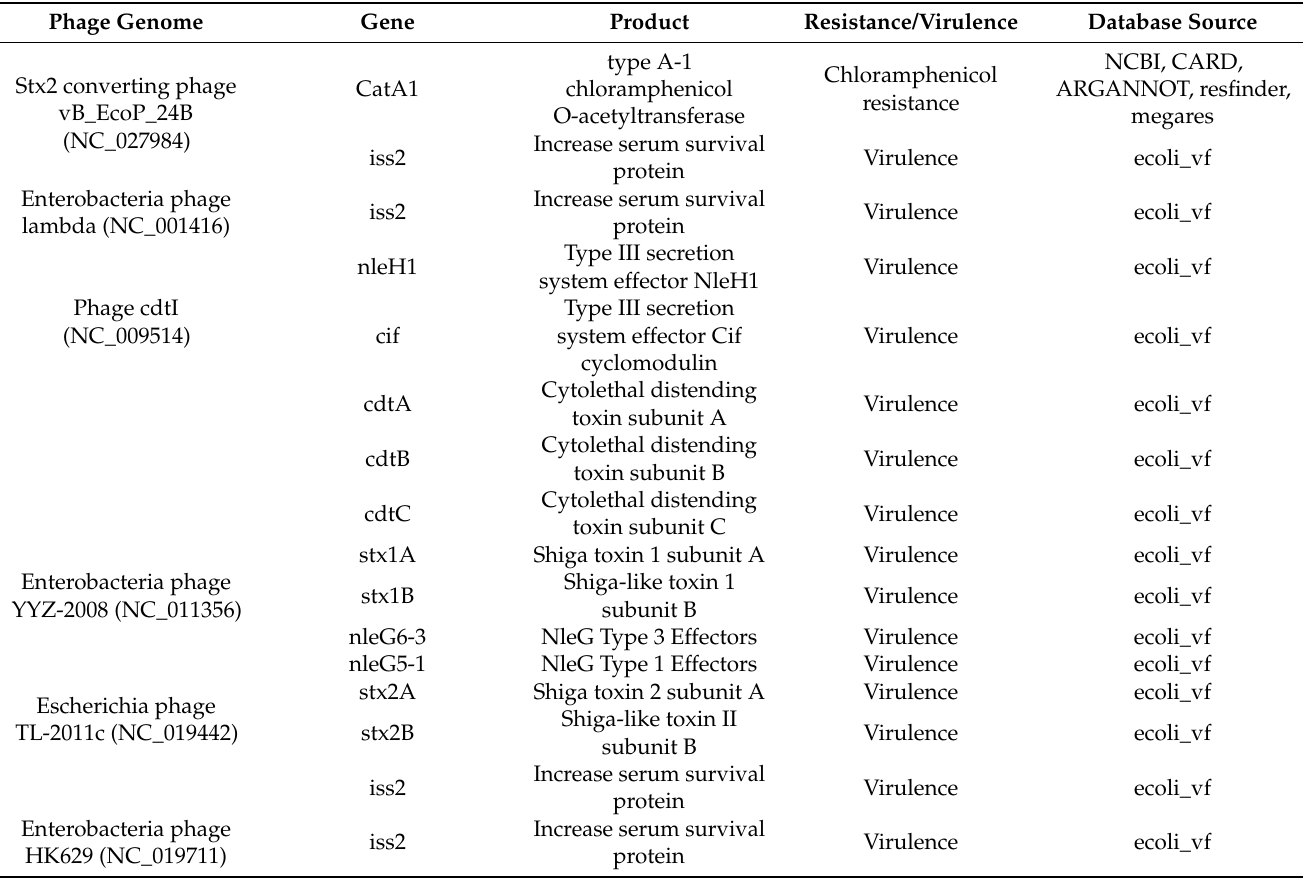
Table 5. Antimicrobial resistance and virulence genes obtained by screening the genome of lytic phages using